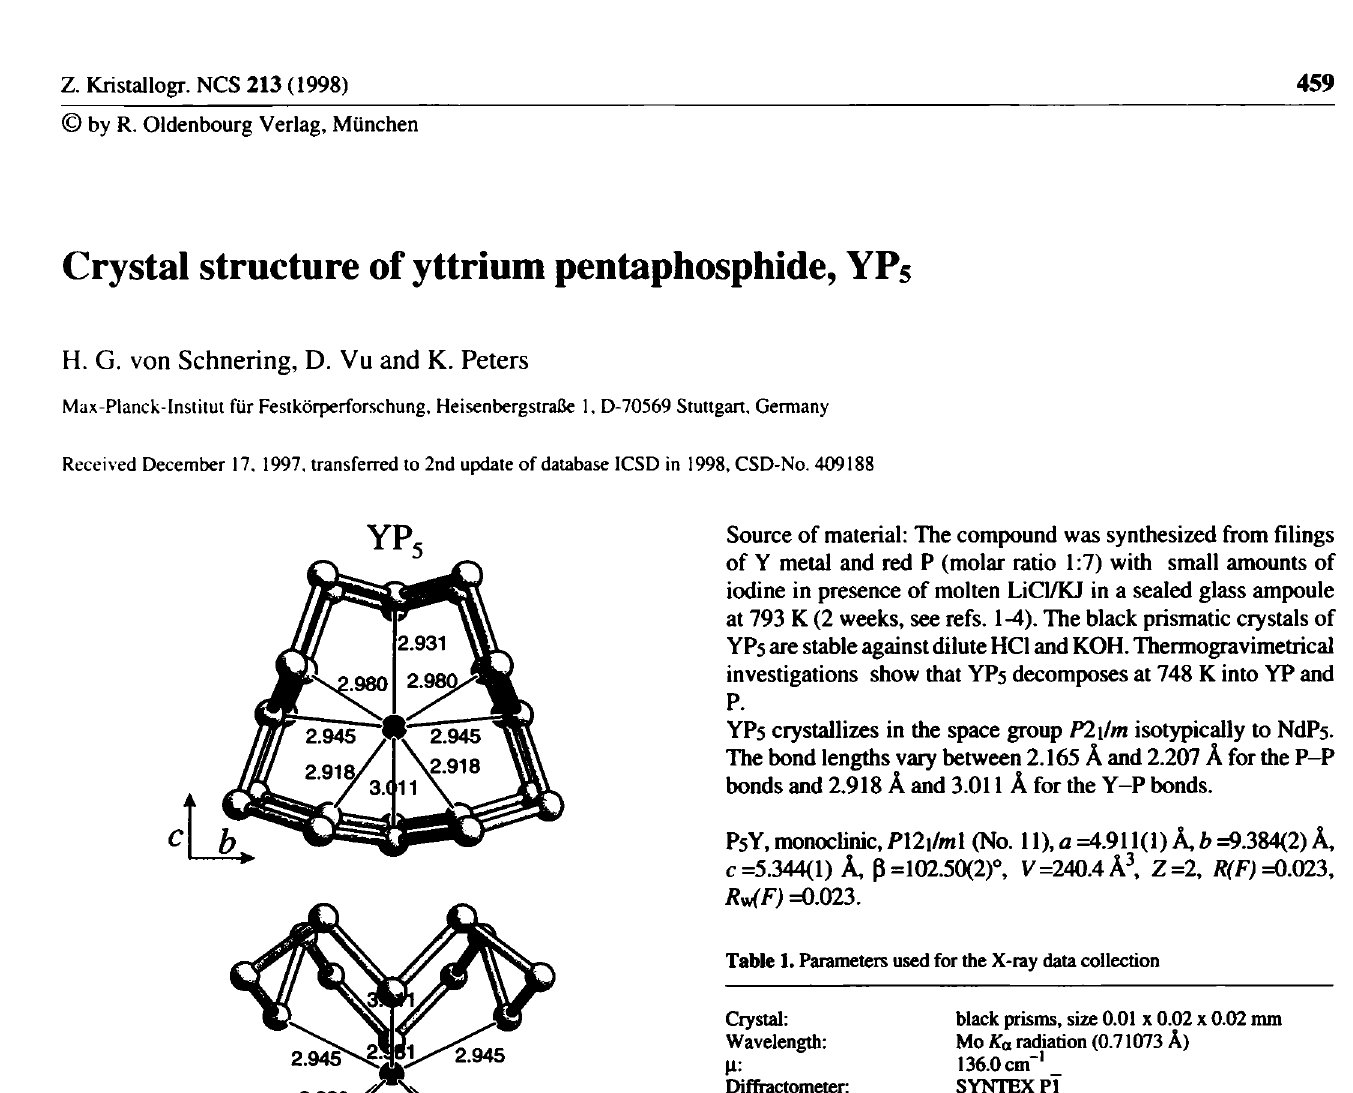
Table 2. Final atomic coordinates and displacement parameters (in